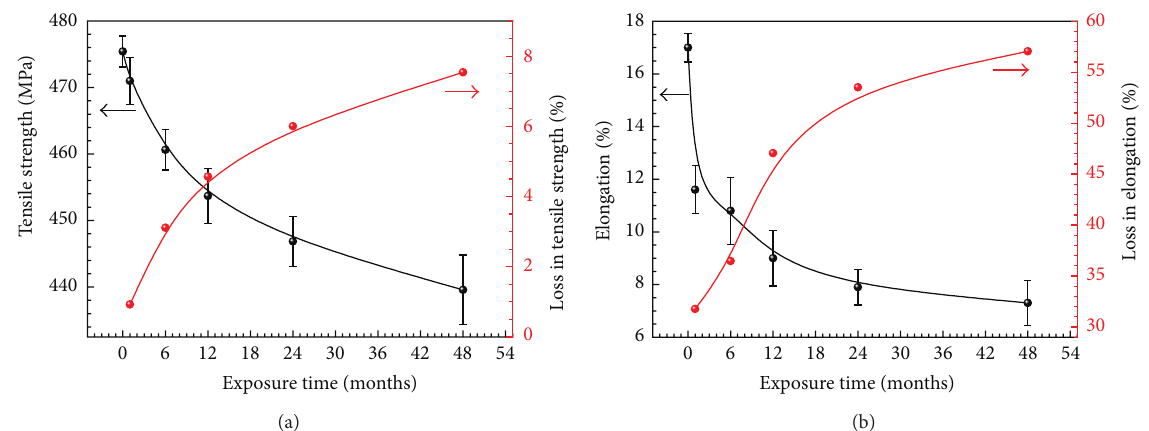
Figure 5: Changes of the tensile strength (a) and elongation (b) of 2A12 alloy exposed for different time.